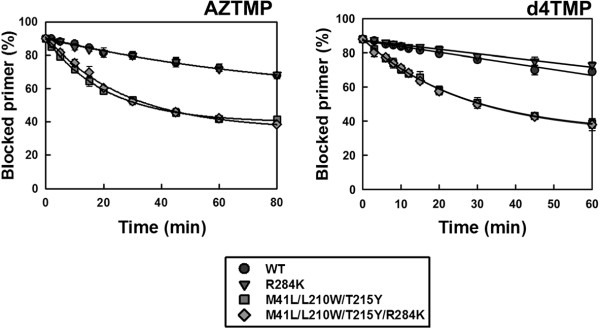
Kinetics of the ATP-dependent excision of AZTMP and d4TMP from DNA/DNA template-primers. Time course experiments for the excision reaction of AZTMP- and d4TMP-terminated primers (26-mers) annealed to their corresponding 38-nucleotide DNA templates (30 nM) were determined in the presence of 3.2 mM ATP. The excision reaction was catalyzed by WT and mutant RTs (210 nM). The calculated kobs values for the AZTMP excision reaction were 2.82 x 10-3 ± 1.48 x10-4 min-1 for WT RT, 2.42 x 10-3 ± 1.22 x 10-4 min-1 for mutant R284K RT, 4.69 x 10-2 ± 1.69 x 10-3 min-1 for M41L/L210W/T215Y RT, and 3.64 x10-2 ± 3.08 x 10-3 min-1 for M41L/L210W/T215Y/R284K RT. For the excision of d4TMP, the kobs values for WT and mutants R284K, M41L/L210W/T215Y, and M41L/L210W/T215Y/R284K were 3.37 x 10-3 ± 1.93 x 10-4 min-1, 2.62 x 10-3 ± 1.42 x 10-4 min-1, 3.72 x 10-2 ± 1.58 x 10-3 min-1, and 3.70 x 10-2 ± 2.29 x 10-3 min-1, respectively.